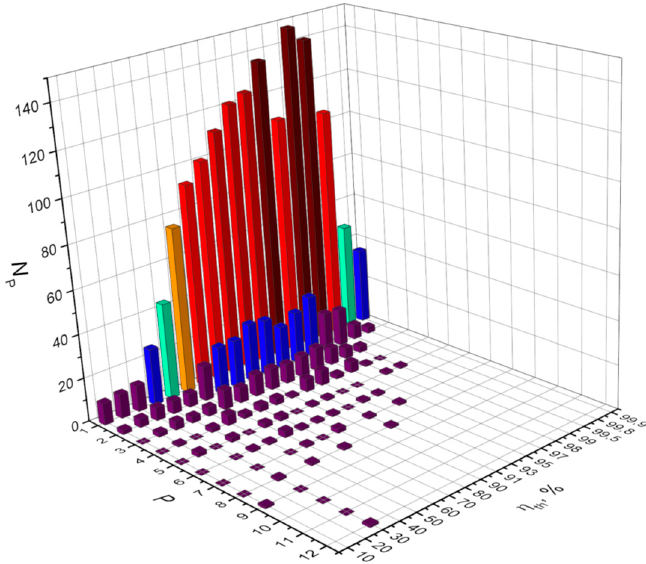
Figure 16. Dependence of solution number for various values of P on the threshold synchronization effectiveness η th ( U n = 80 µV).